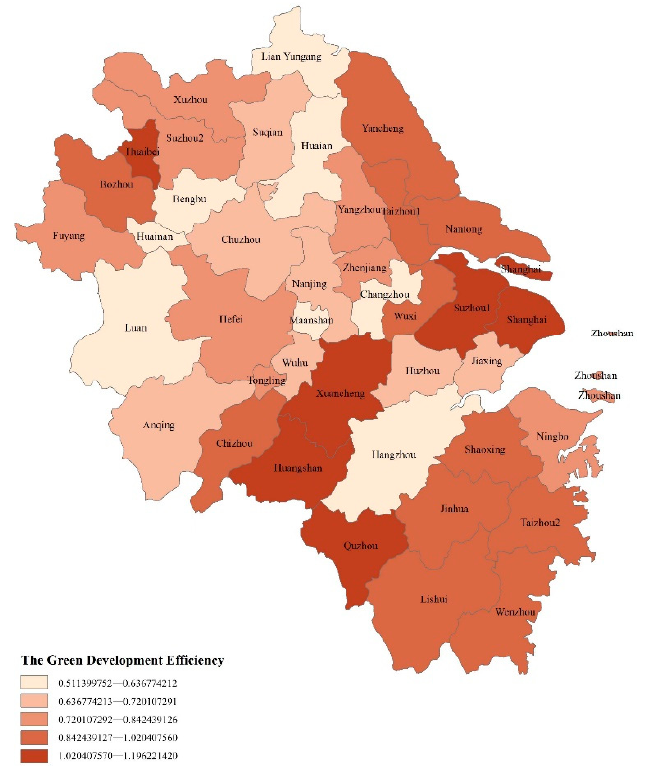
Figure 3. Geospatial distribution of 10-year mean GDE in the Yangtze River Delta. Note: the figure was made by the authors.